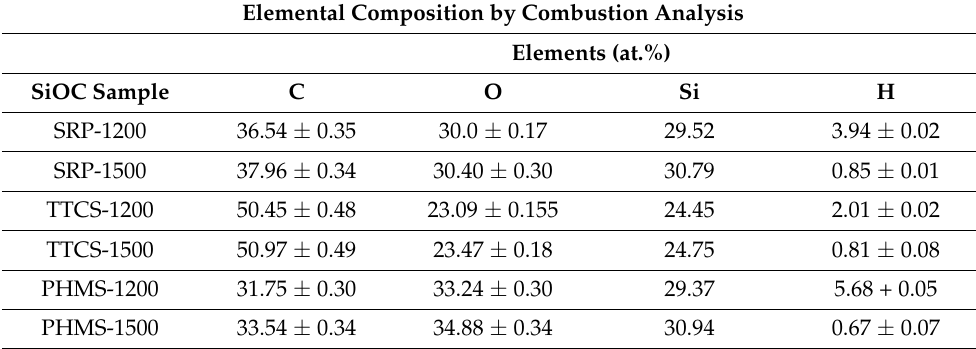
Table 1. Elemental analysis of SiOC samples by combustion